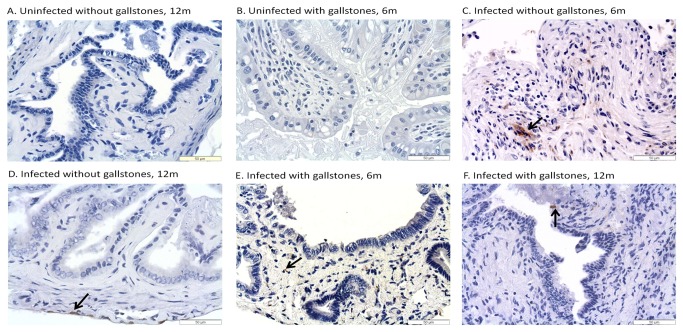

Salmonella LPS staining was frequently detected in the gallbladder of infected mice regardless of the presence of gallstones.Representative IHC images of mouse gallbladder tissue at 6 and 12 months post-infection using an anti-Salmonella LPS antibody. Such bacterial staining occurs at time points in which no CFU were detected from the gallbladder of cage mates. Black arrows show Salmonella LPS staining in the muscularis (Panel C and D), in the epithelium (Panel E) or in the lumen (Panel F). DAB and hematoxylin counterstain. 40x.